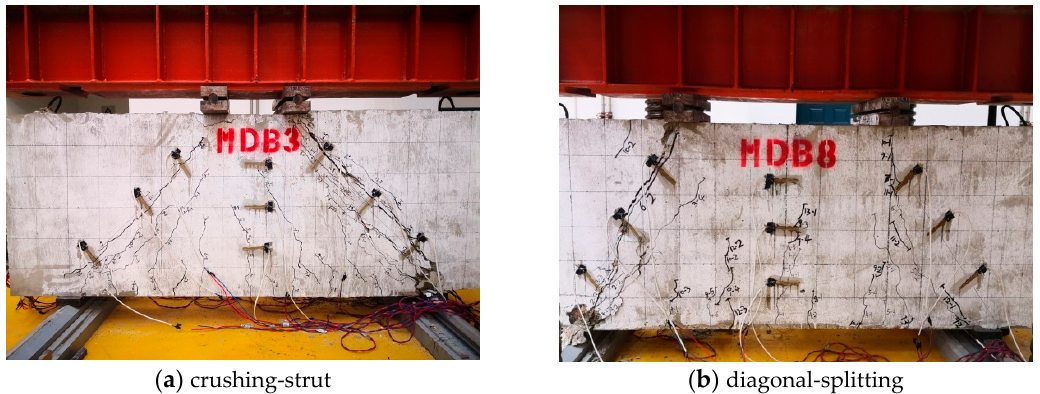
Figure 6. Failure mode of deep beam.